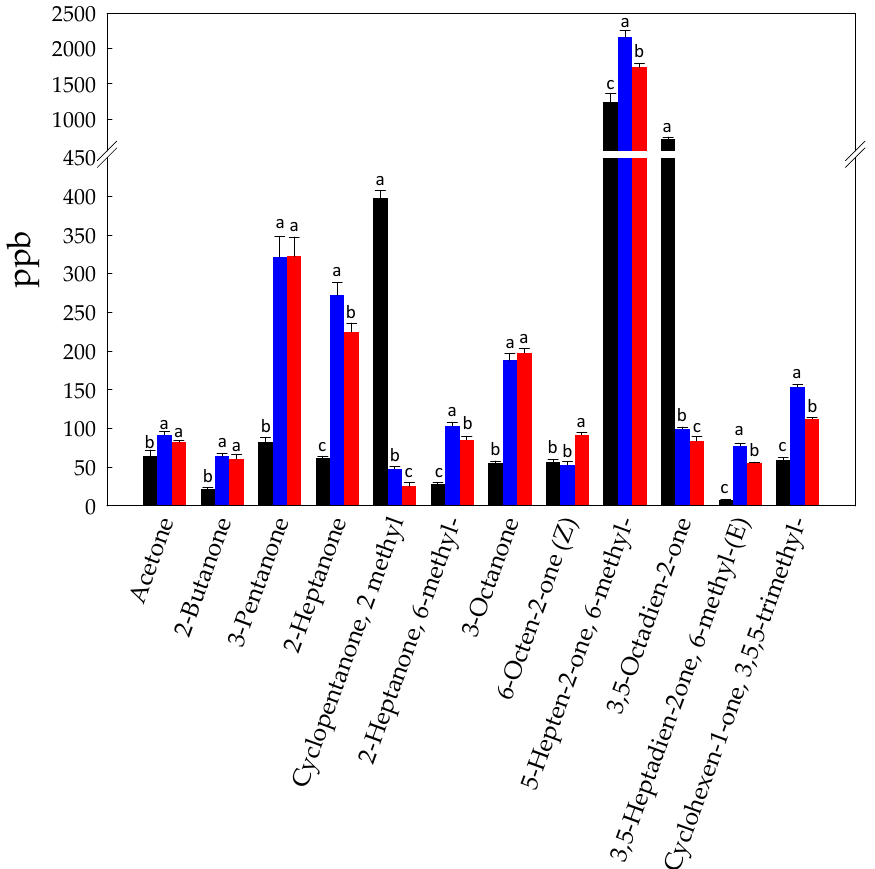
Figure 3. Concentration (ppb) of ketones identified in Raw- (black bars), Unstarted- (blue bars), and Started-BCP (red bars). Data are the means ( ± SD) of three independent experiments analyzed in triplicate. Data were subjected to one-way ANOVA; pair-comparison of treatment means was achieved by Tukey’s procedure at p < 0.05. For each compound, bars with different superscript letters differ significantly ( p < 0.05).